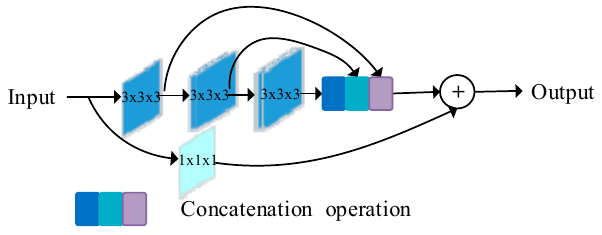
Figure 2. MultiRes block diagram (Reprinted with permission from Ref. [29]. Copyright 2020 Else- vier).